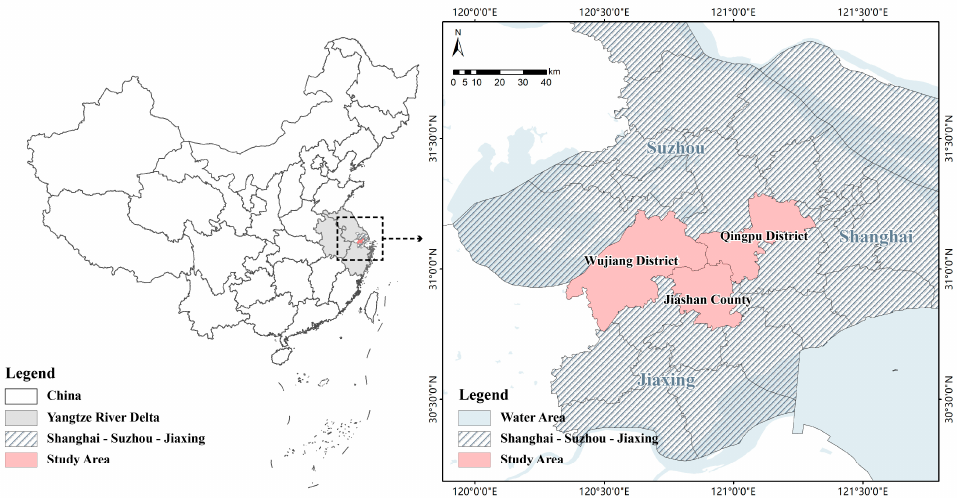
Figure 1. Location of the demonstration area.